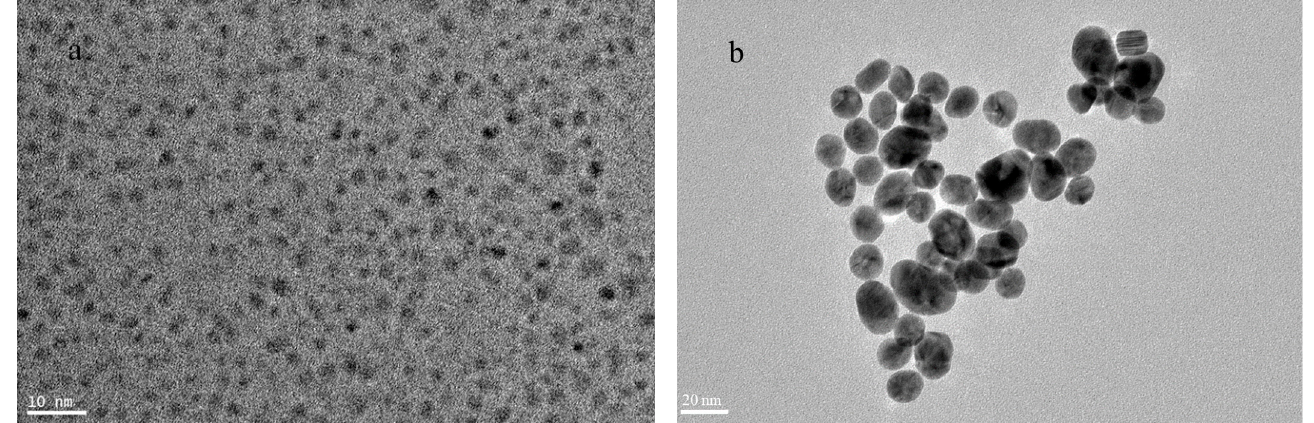
Figure 1. TEM images of synthesized CdTe QD ( a ) and AuNP ( b ).